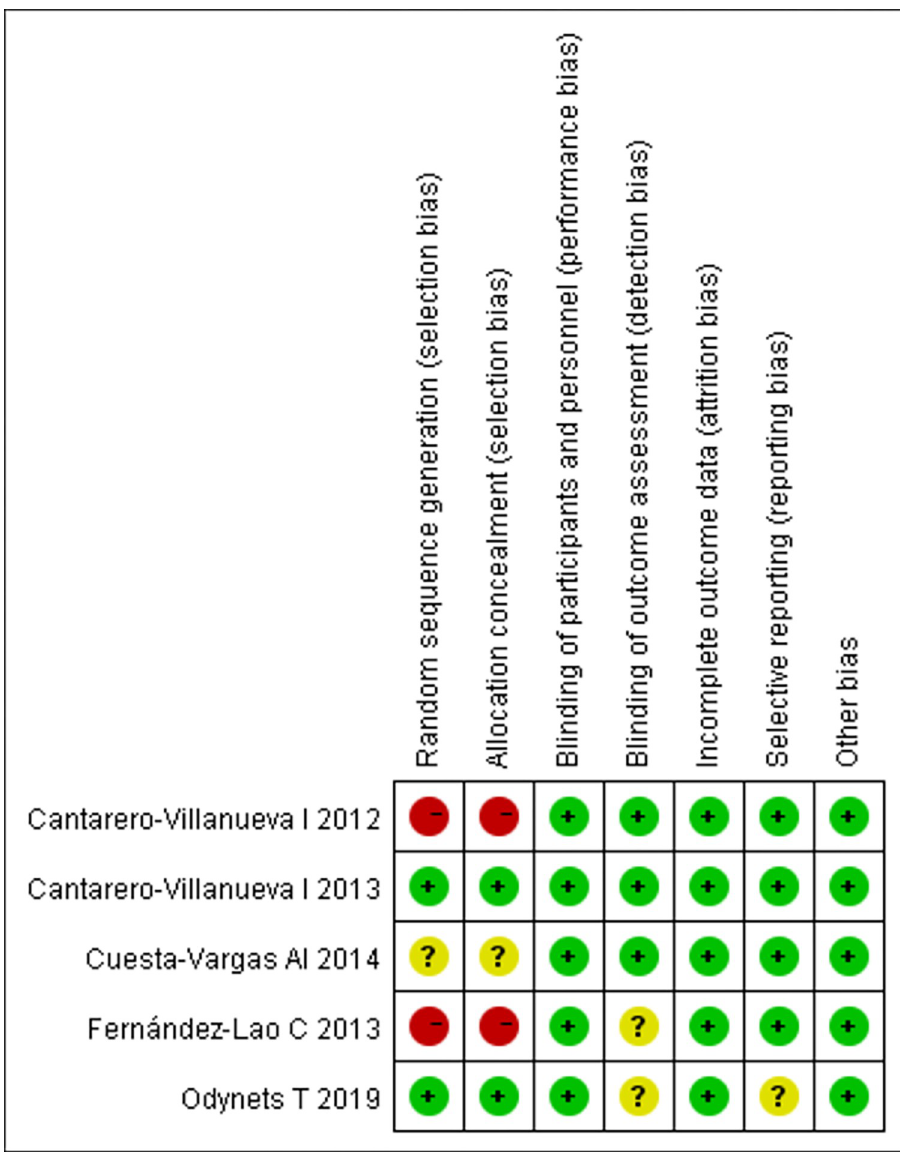
Fig 3. Risk of bias summary.